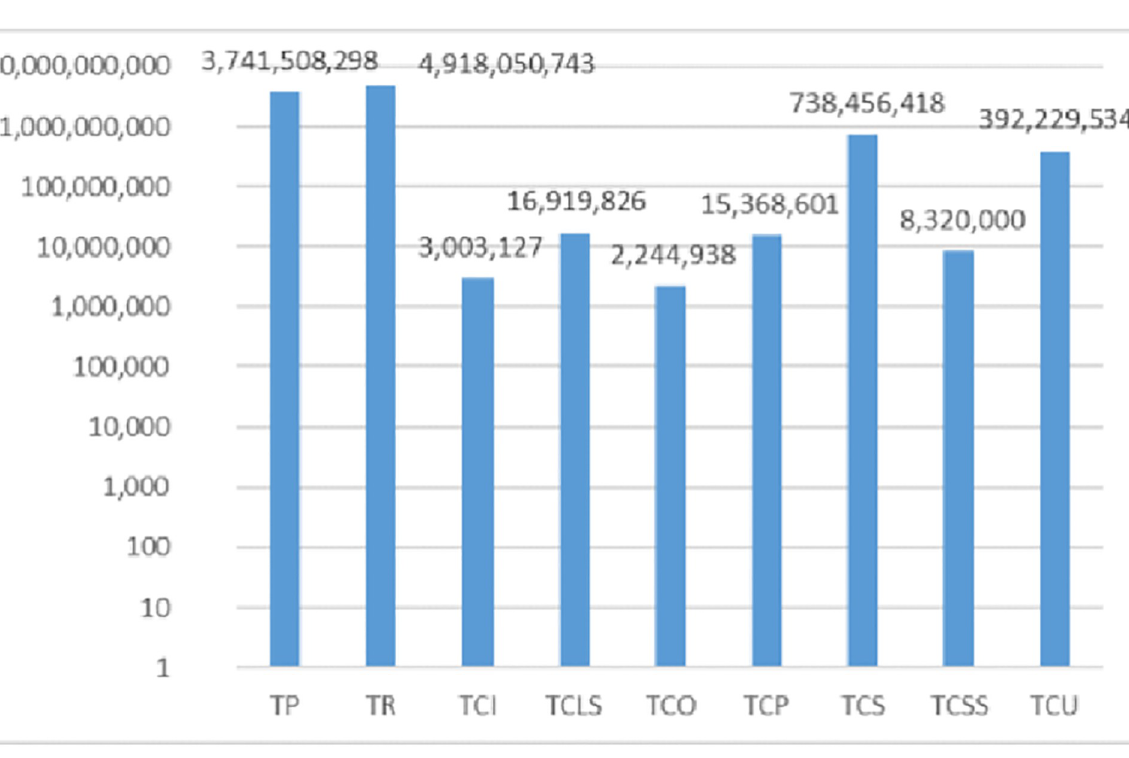
Fig 13. The costs and total profit of the real case